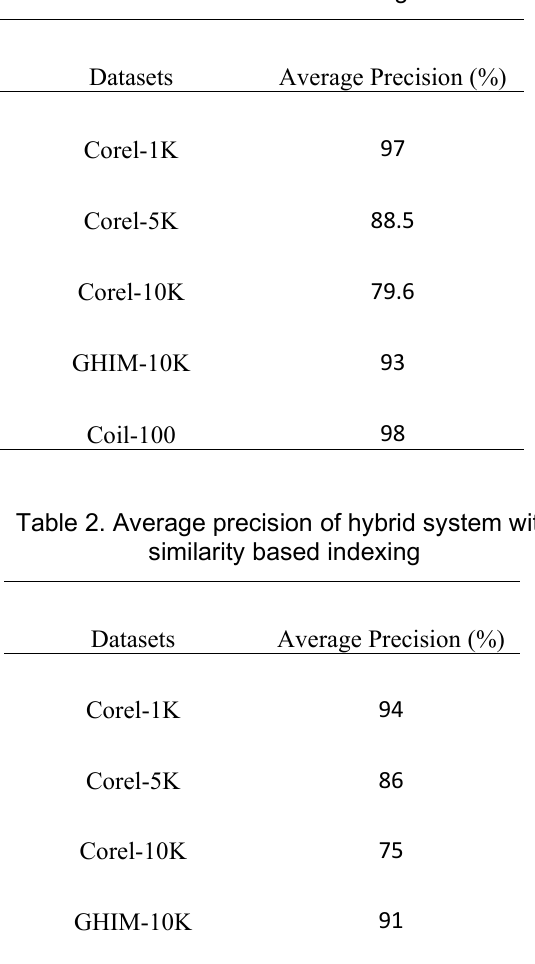
Table 1. Average precision of hybrid system with